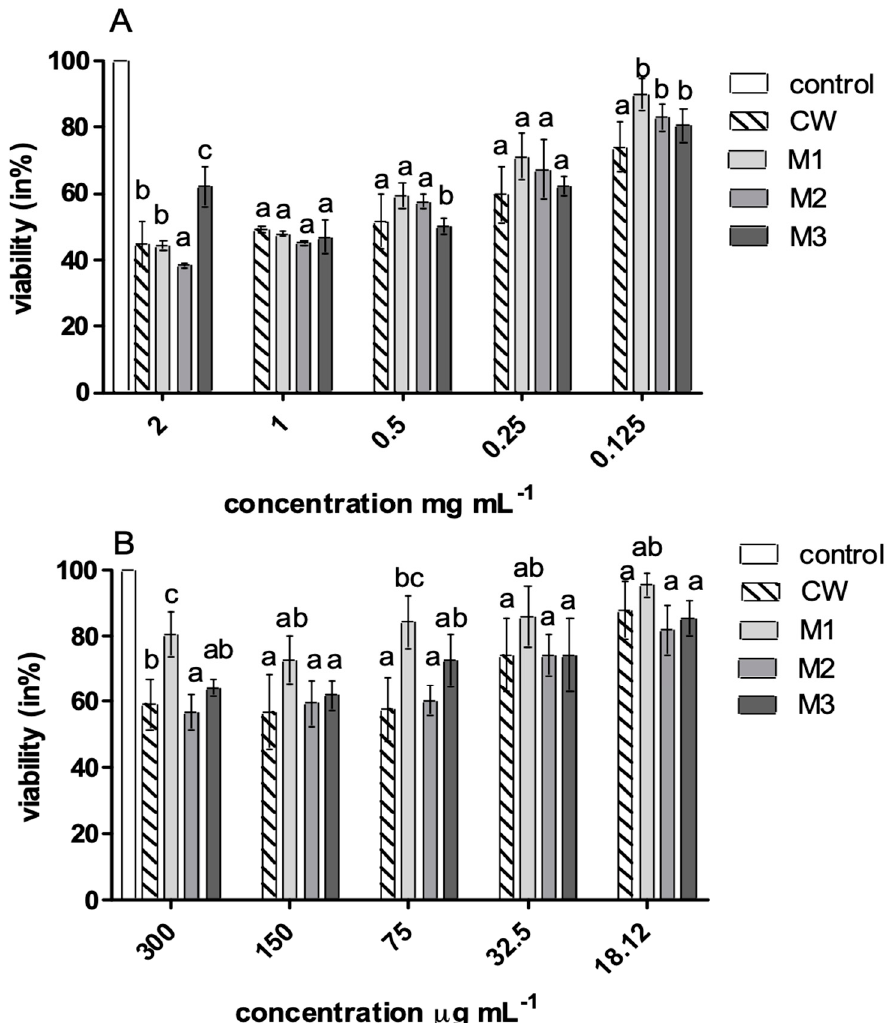
Figure 3. Viability (in %) of L. monocytogenes ATCC BBA-2660 against hydrolysates ( A ) and peptide fractions ( B ); control—growth of bacteria without hydrolysates or peptide fractions, CW—wheat wafers, M1, M2, and M3—wheat wafers enriched with 1%, 2%, or 3% ( w / w ) of millet flour, respectively. Di ff erent letters indicate significant di ff